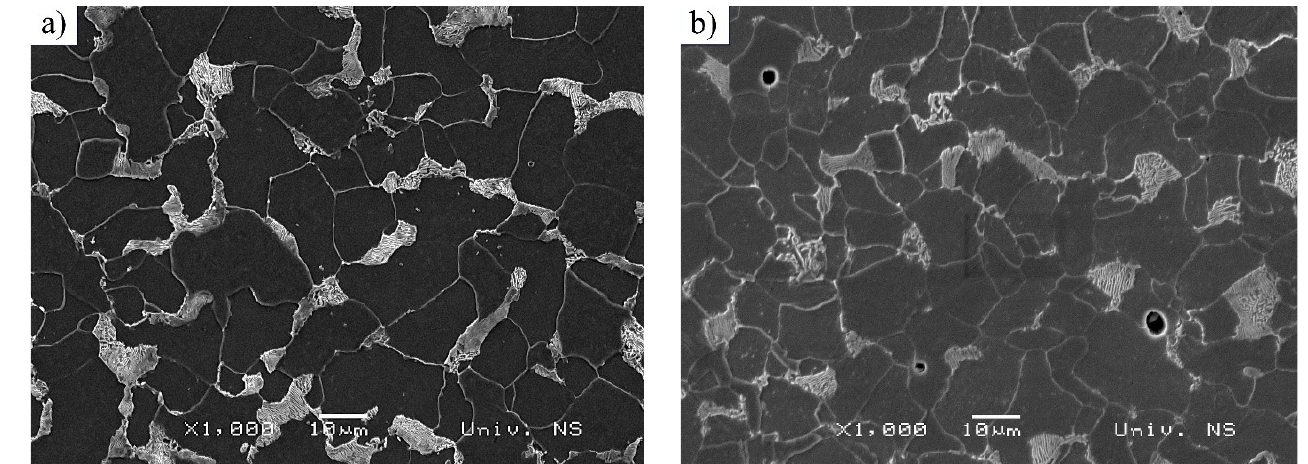
Figure 6. Microstructure of tested steels (as-received materials)—images taken using SEM micro- scope: ( a ) S235JRC+C steel and ( b ) C15E+C steel ( a ) S235JRC+C steel and ( b ) C15E+C steel.